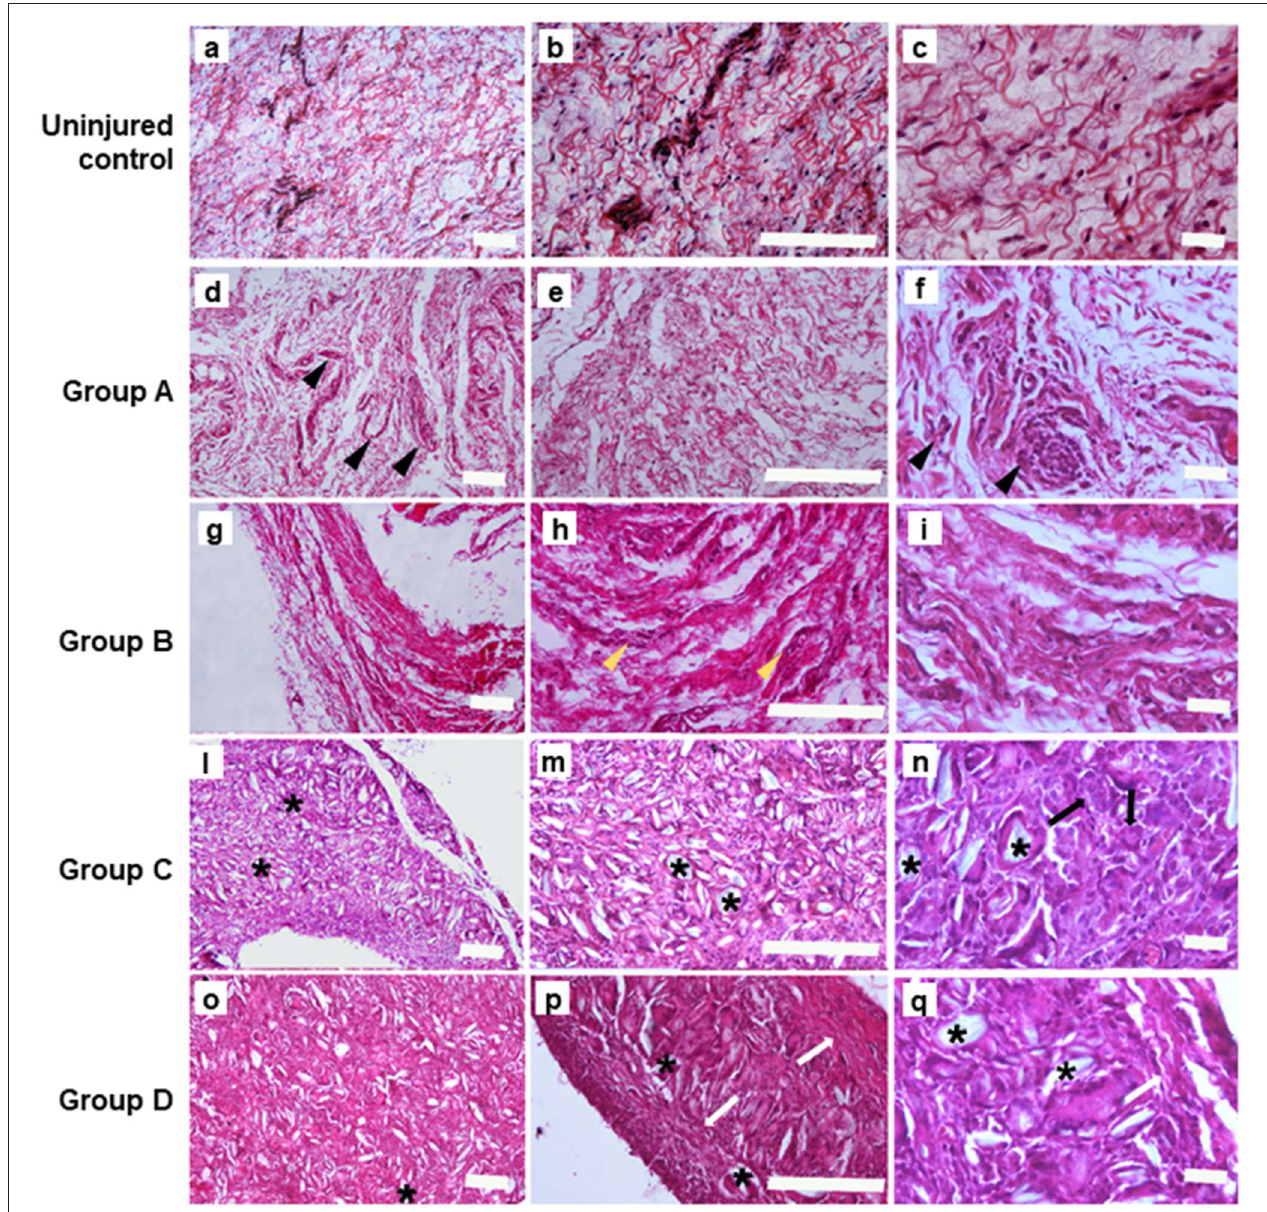
FIGURE 2 | Hematoxylin&Eosin staining performed on the samples at 4 weeks. (A–C) Uninjured lesions (Scale bars: a, b 100 µ m; c 20 µ m); (D–F) . Group A: control lesions obtained only by incision and milling, note the presence of leucocytes (pointed arrow) (Scale bars: d, e 100 µ m; f 20 µ m); (G–I) . Group B: lesions obtained by incision an injection of 16 mg/ml of talc (Scale bars: g, h 100 µ m; i 20 µ m); in (H) yellow pointed arrows depict the reactive vascular component; (L–N) . Group C: lesions obtained by incision with 160 mg/ml of talc injection; note the presence of talc crystal (*) and multigiant cells (->) (Scale bars: l, m 100 µ m; n 20 µ m); (O–Q) . Group D: Lesions obtained by incision with injection of and 300mg/ml of talc, note the presence the presence of fibrotic capsule (white arrow) around the talc residuals (*) (Scale bars: o, p 100 µ m; q 20 µ m).